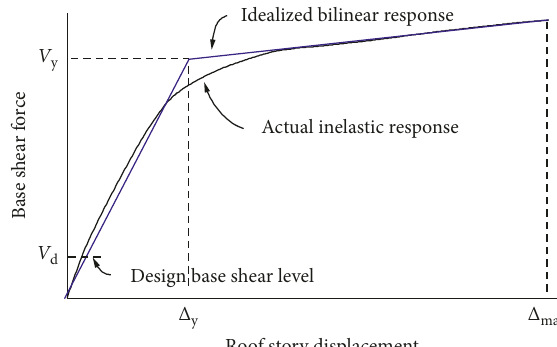
Figure 22: Idealized base shear-roof displacement relationship of a structure.